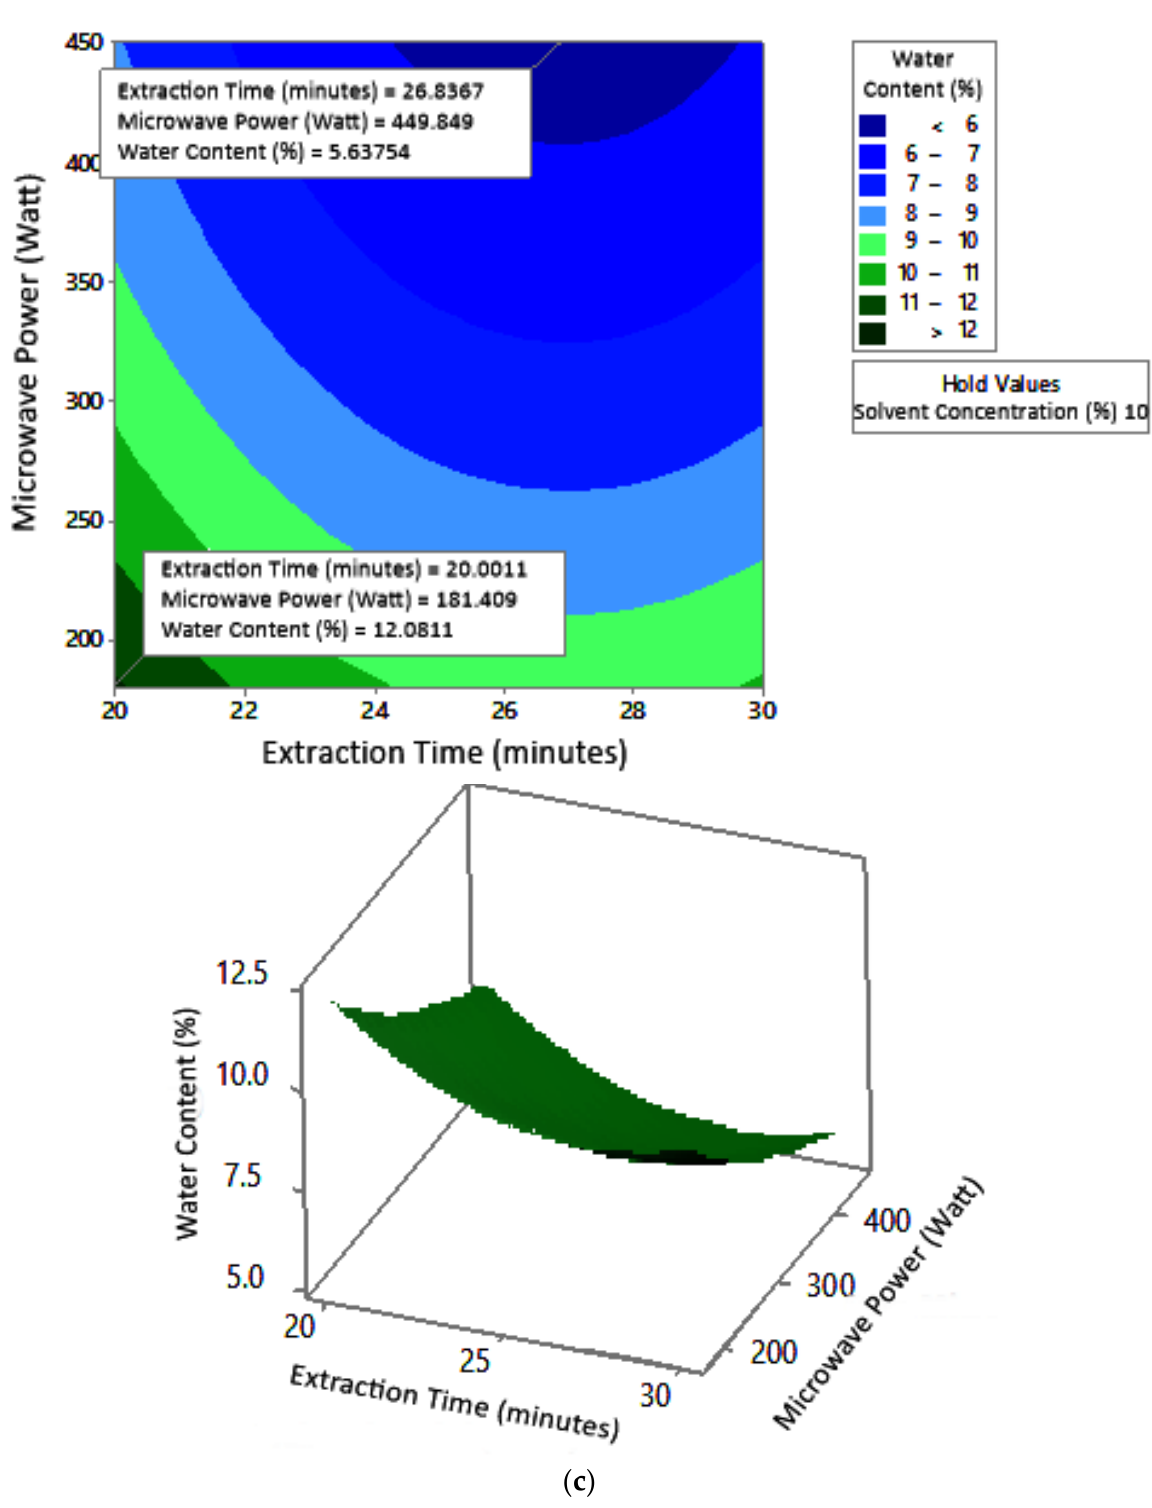
Figure 8. Effect of extraction time and microwave power on water content at solvent concentrations: